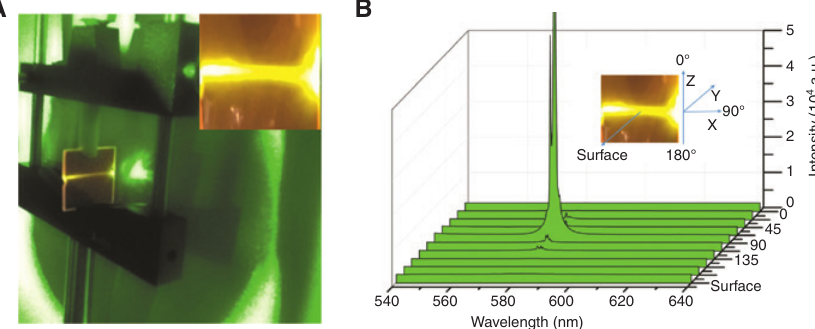
Figure 8: The formation mechanism and randomness of random Lasers observed in LOPP. The random lasing emission and far filed images LOPP (A), the 3D waterfall of LOPP with different reception angle of spectrometer and reception diagram